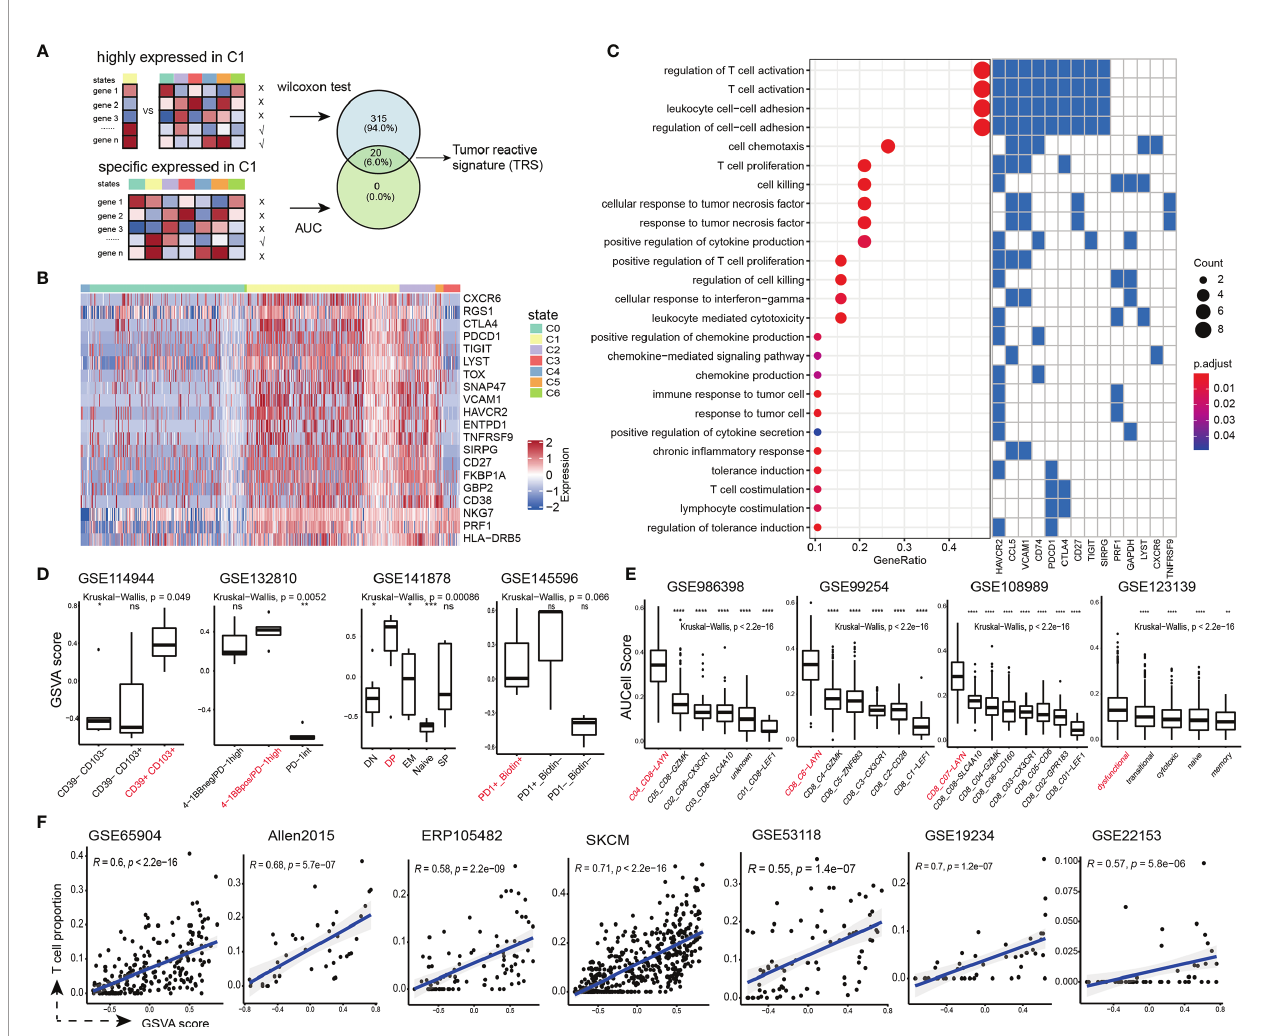
FIGURE 3 | Development and validation of the TRS signature. (A) The framework to screen the TRS. (B) Heatmap showing the expression of the TRS in single cells. (C) (Left panel) Enriched GO terms of TRS. (Right panel) Genes involved in each GO term (D) Distribution of the TRS scores of tumor-reactive T cell group (colored by red) and other T cell groups. (E) Distribution of the TRS scores of T cell states in additional scRNA-seq datasets of liver cancer (GSE986398), non-small cell lung cancer (GSE99254), colorectal cancer (GSE108989) and melanoma (GSE123139). The exhausted T cell state is colored by red. Wilcoxon rank-sum tests were used to assess the signi fi cance of pairwise comparisons, and Kruskal-Wallis tests were used for overall comparisons. ns denoted non-signi fi cant, * denoted p < 0.05, ** denoted p <0.01, *** denoted p < 0.001, and **** denoted p < 0.0001. (F) Spearman correlation between the TRS scores and the proportions of T cell in fi ltration in bulk melanoma samples obtained from GSE65904, Allen2015, ERP105482, SKCM, GSE53118, GSE19234, and